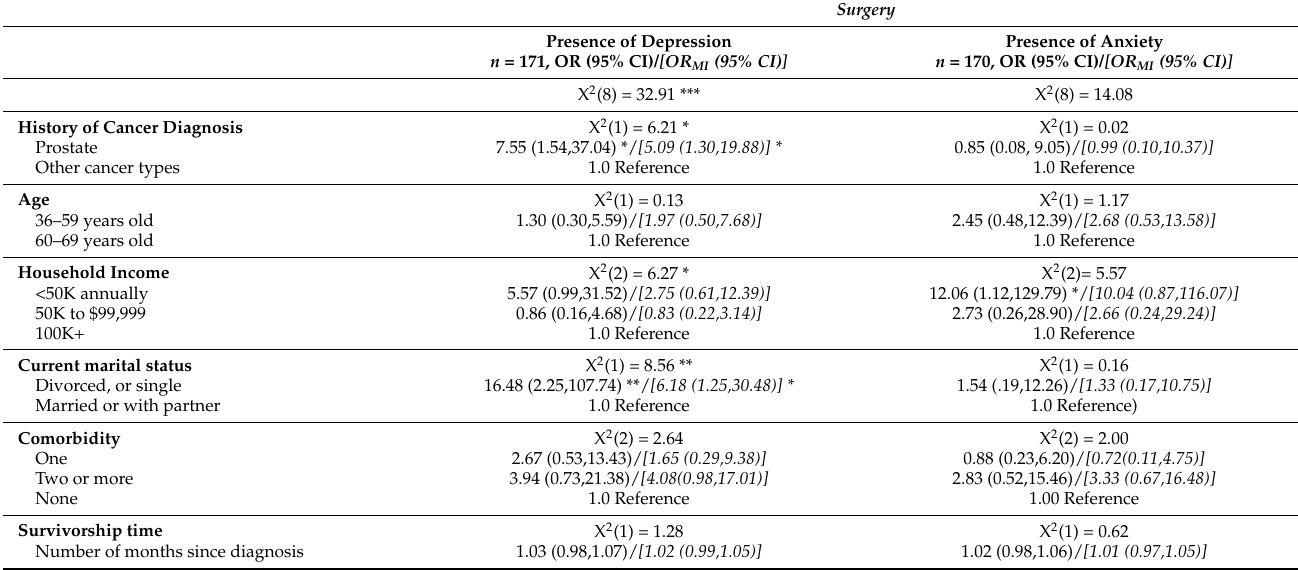
Table 2. Stratified binary logistic regression analysis by treatment modality predicting screening positive for depression or anxiety by history of cancer and covariates among adult men residing in Atlantic Canada, aged 36+, between 2009 and 2015, ( n =